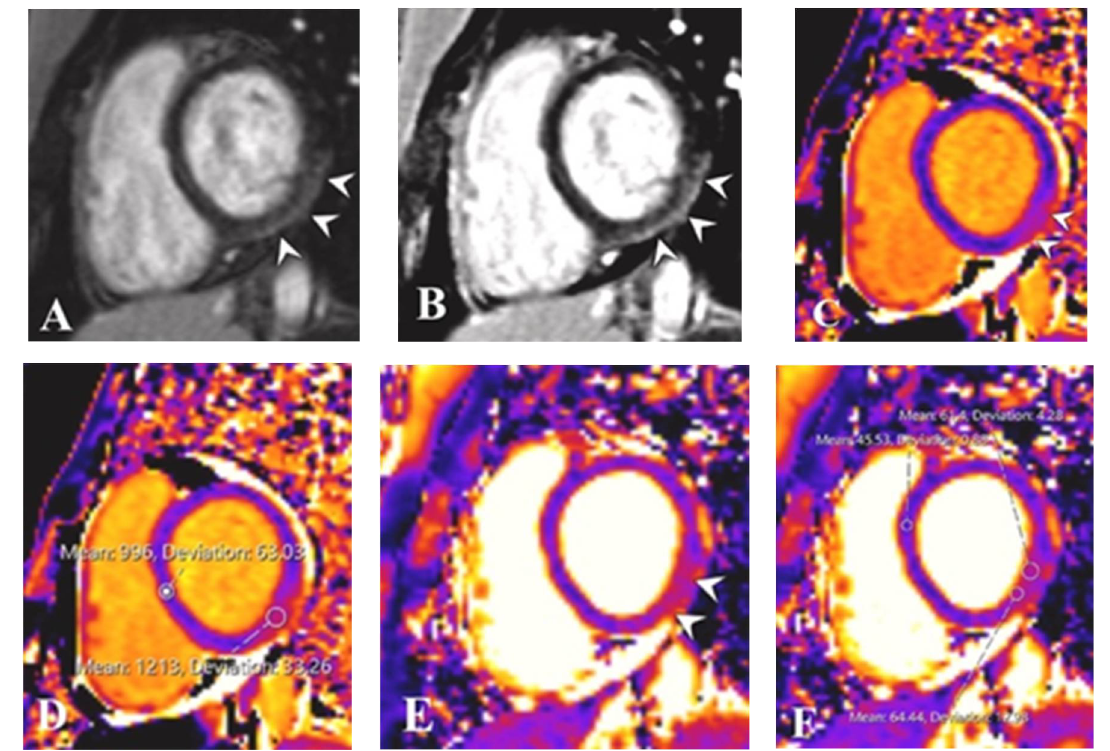
Figure 4. Magnetic Resonance Imaging of Case 2. Post-contrast magnitude inversion recovery (MAG-IR) ( A ) and phase-sensitive inversion recovery (PSIR) ( B ) images in short-axis views show subepicardial enhancement in the inferolateral wall at the base (arrowheads). Native T1 map shows corresponding abnormality (arrowheads in ( C )) with elevated values ( D ) in the inferolateral wall compared with the interventricular septum. T2 mapping also showed abnormality in this region (arrows in ( E )) with elevated values ( F ) when compared with the interventricular septum. Reprinted/adapted with permission from Ref. [15] 2021, Elsevier.